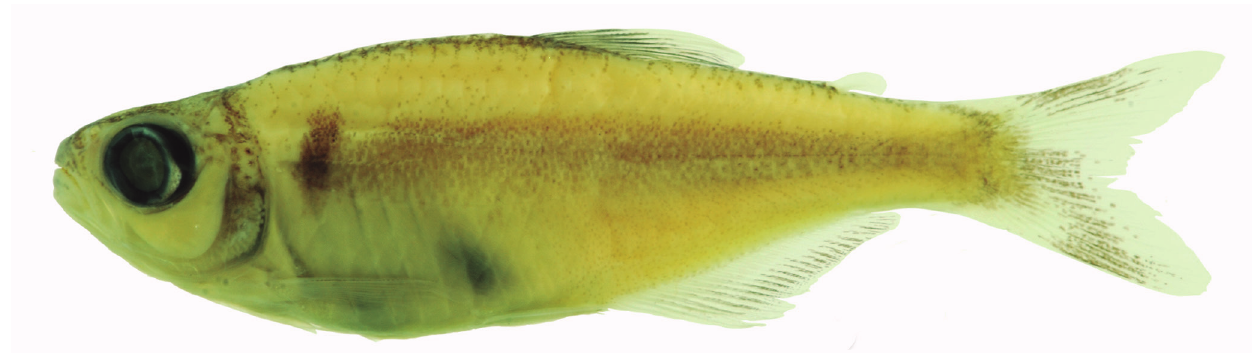
Fig. 1. Holotype of Boehlkea weitzmani , INPA 53202, 33.7 mm SL, male, rio Japurá basin, Amazonas State,